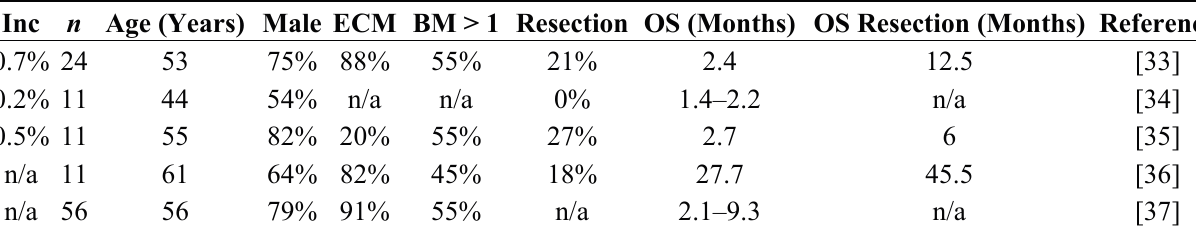
Table 3. Clinical studies analyzing characteristics and survival of patients diagnosed with brain metastases originating from gastric